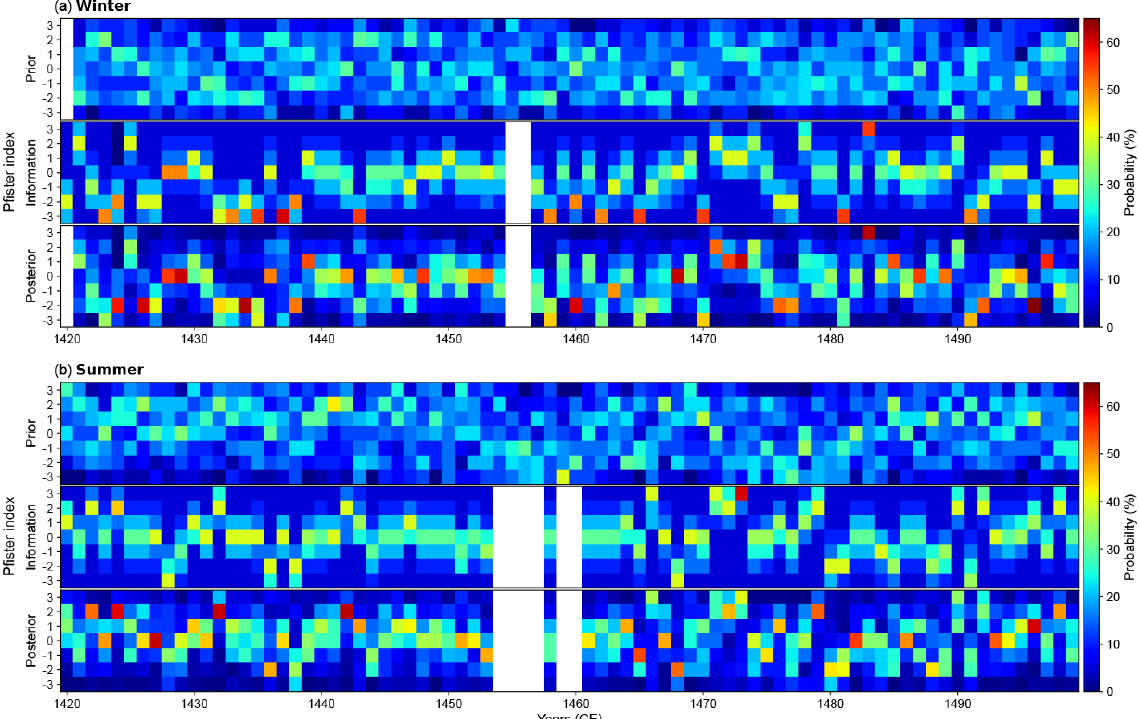
Figure 4. Prior, historical information, and posterior probability distributions of seasonal temperatures in the Burgundian Low Countries for (a) winters and (b) summers ranging from 1420 to 1499CE. Top panels represent the prior probability distribution, p (climate), extracted from 2m air temperatures of the 40-member ModE-Sim ensemble and converted into Pfister indices. Middle panels illustrate the probability distribution of the information, p (observations | climate) /p (observations), acquired from historical archives compiled and converted into Pfister indices by historians. Bottom panels depict the posterior probability distribution, p (climate | observation). White spaces are shown when there are no observations available and therefore the posterior matches the